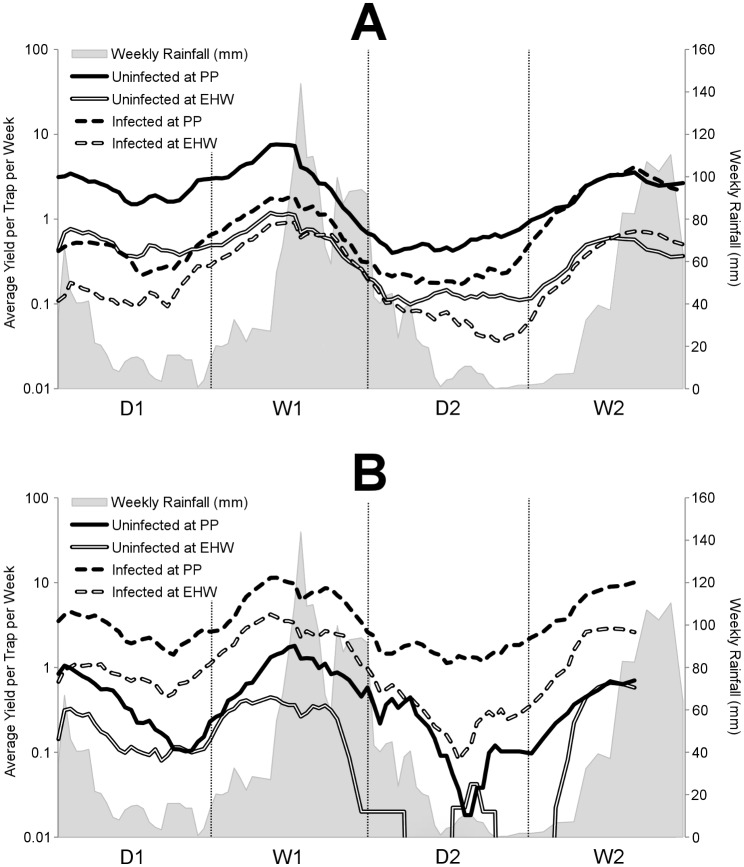
Average trap captures for infected and uninfected Ae. aegypti.Ae. aegypti caught offsite (A) and onsite (B) are graphed atop weekly Cairns rainfall. Yields and rainfall are smoothed using a moving average of the 5 most recent observations. Trap yields are plotted on a logarithmic scale to show comparative rates of change. After accounting for the seasonal trend in abundances, uninfected mosquito yields offsite (A) decreased over time at both Parramatta Park (PP) and Edge Hill/Whitfield (EHW). Offsite yields of infected mosquitoes increased at PP towards the end of the study but remained relatively constant at EHW. Onsite (B) yields of infected mosquitoes remained relatively constant at EHW and PP, while uninfected mosquito yields decreased heavily in the second dry season (D2) but recovered in the following season.